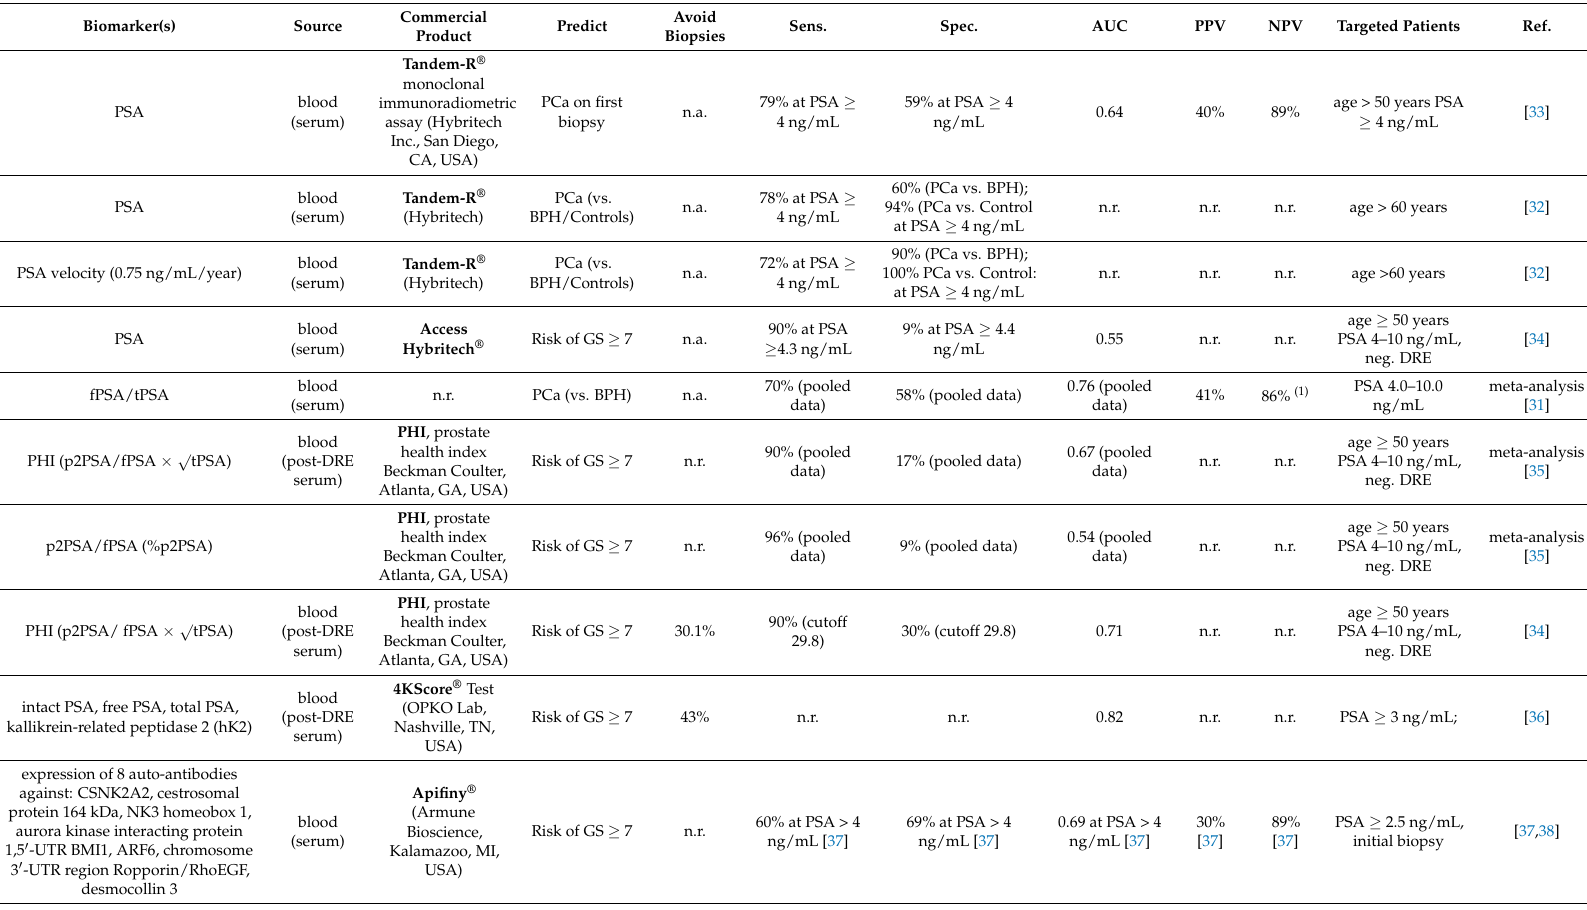
Table 1. PCa biomarker tests for prediction of high-grade PCa (GS ≥